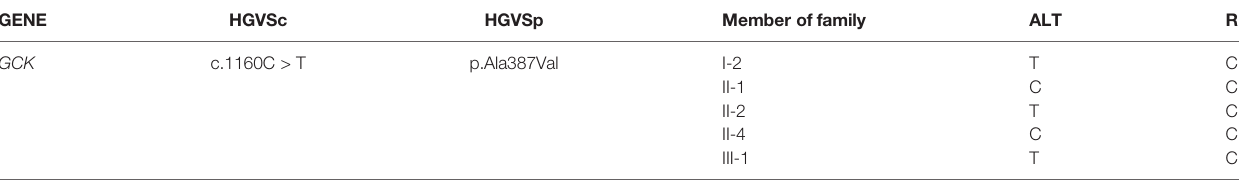
TABLE 6 | Sanger sequencing results of the c.1160C > T mutation in the GCK gene in 200 non-related healthy controls. Subjects Number of people carrying the mutation non-related healthy controls ( n =200) 0